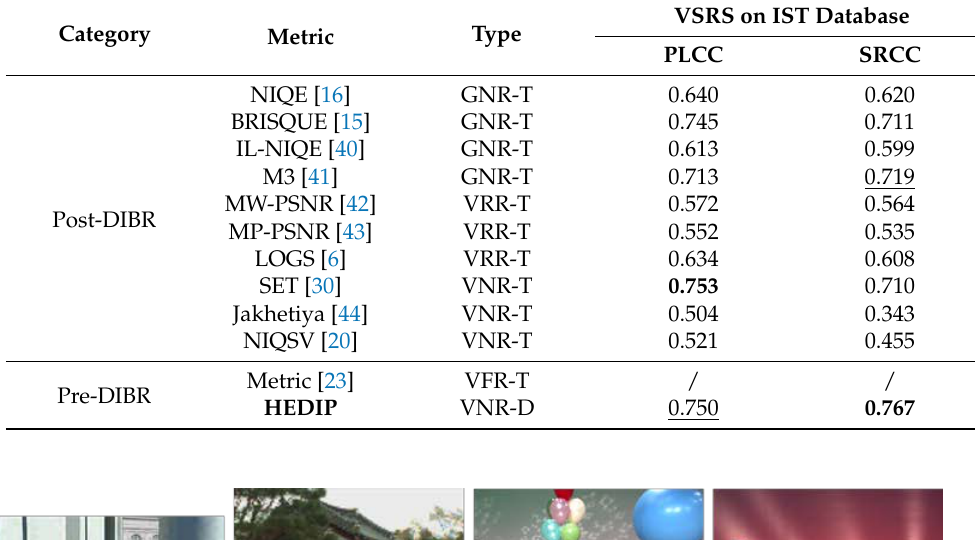
Table 5. Performances of view synthesis quality metrics on the VSRS-based IST database. The best result is highlighted in boldface, and the second best result is underlined.